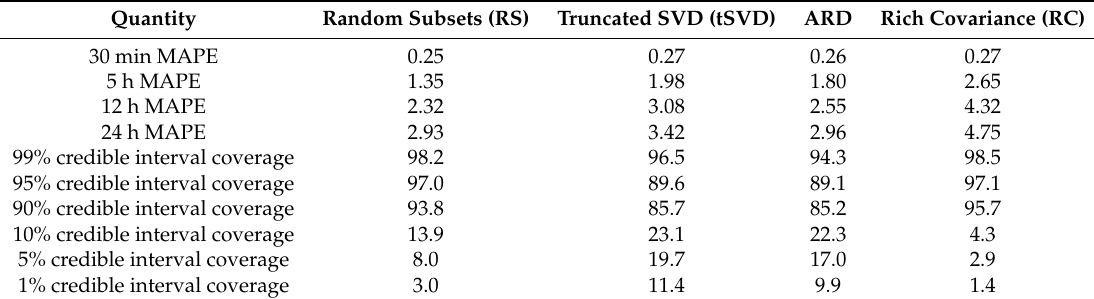
Table 5. Results for the four methods described in Section 2.6, averaged over 576 forecasts (new forecasts every 15 min for six days). The credible interval coverage is a Monte Carlo approximation to the true coverage. It represents the percentage of data points in the test period that fall below the corresponding credible interval using 1000 samples from the posterior distribution. The kernels used for the models in Table 5 are described in Appendix